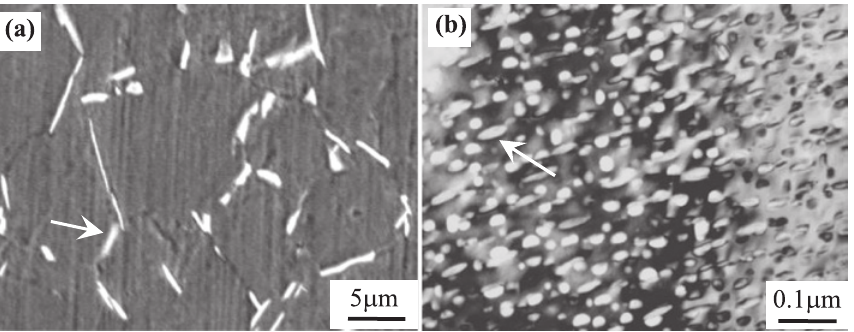
Fig. 1: Microstructures of GH4169 alloy after standard head treatment. (a) Acicular and short rod-like phase precipitating along the grain boundaries, (b) microstructure of γʹ phase and γʹʹ phase in the matrix